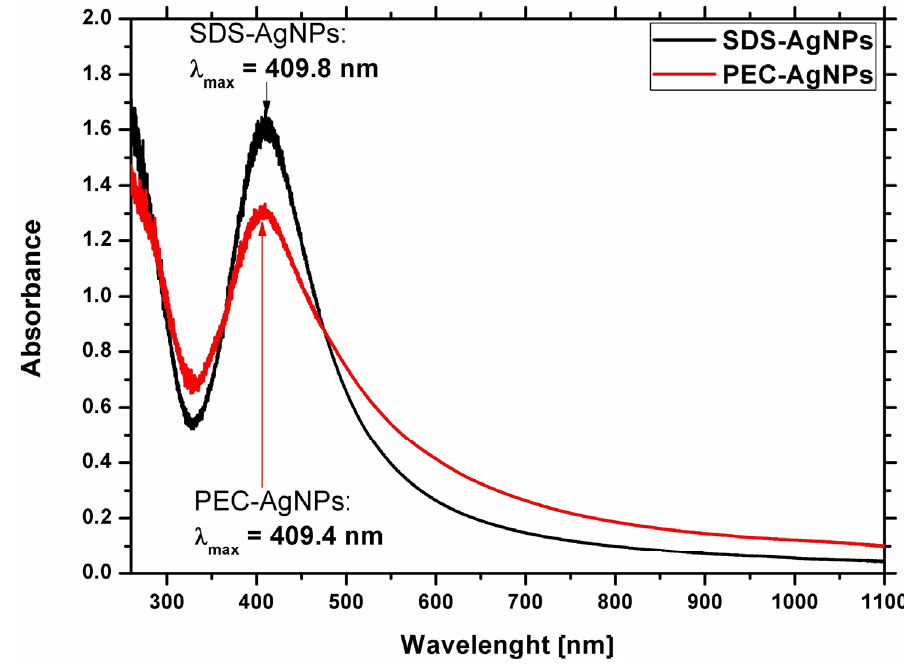
Figure 1. UV/Vis absorption spectra of Ag nanostructures, stabilized by pectins (PEC) (red line) or sodium dodecyl sulphate (SDS) (black line).